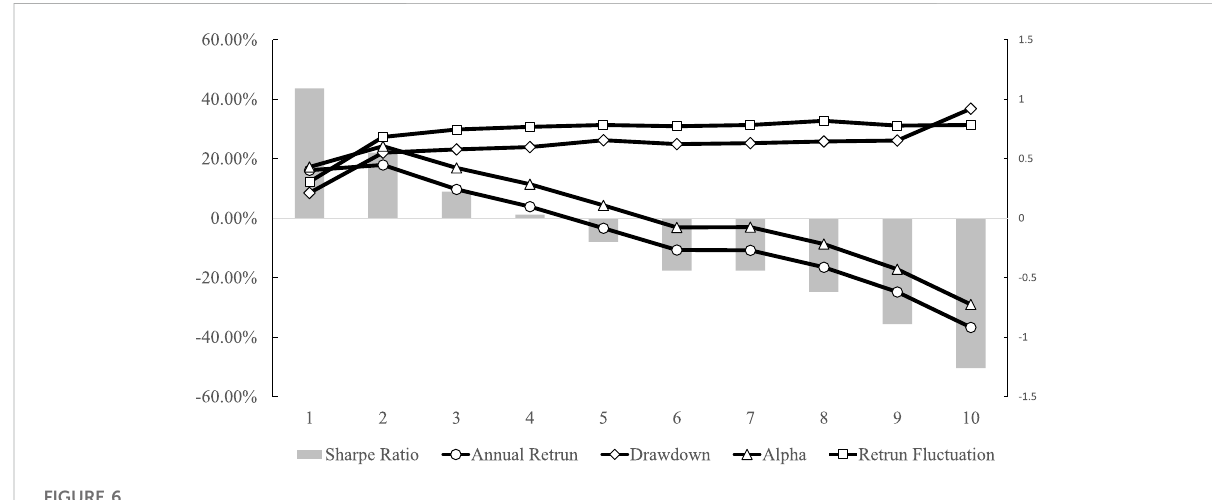
FIGURE 6 Performanceofeachindicatoronback-testing.Thehorizontalaxisrepresentsthetengroups,theleftverticalaxisrepresentsthepercentagefor annual return, drawdown, Alpha, and return fl uctuation, and the right vertical axis represents the value of the Sharpe ratio. Five indicators are illustrated in Figure 6, including the Sharpe ratio as the histogram, annual return as a line with hollow circles, drawdown as a line with hollow diamonds, Alpha as a line with triangles, and return fl uctuation as a line with squares. The return fl uctuation and drawdown lines are positively correlated with the collective investor attention, while the other three lines are negatively correlated with the collective investor attention.